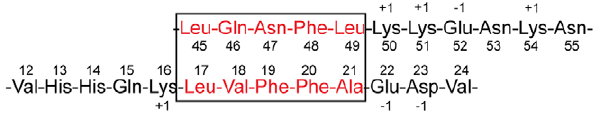
Figure 7. Amino acid sequence alignment of S100A9 in the hinge region and A b 12–24 peptide. The hydrophobic cores of both proteins are marked in red. The charged residues are indicated with their approximate charges. All sequences were obtained from the SWISS-PORT protein database [26].